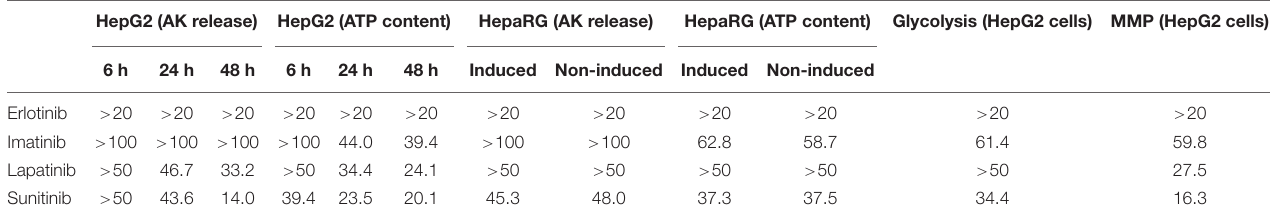
EC 5 0 values were calculated using GraphPad Prism 6 as described in Methods based on the data provided in the corresponding figures. Incubation times in HepG2 cells for AK release and ATP content were as indicated and 48 h for HepaRG cells, glycolysis and the MMP. Units are µ M. AK, Adenylate kinase; MMP, mitochondrial membrane